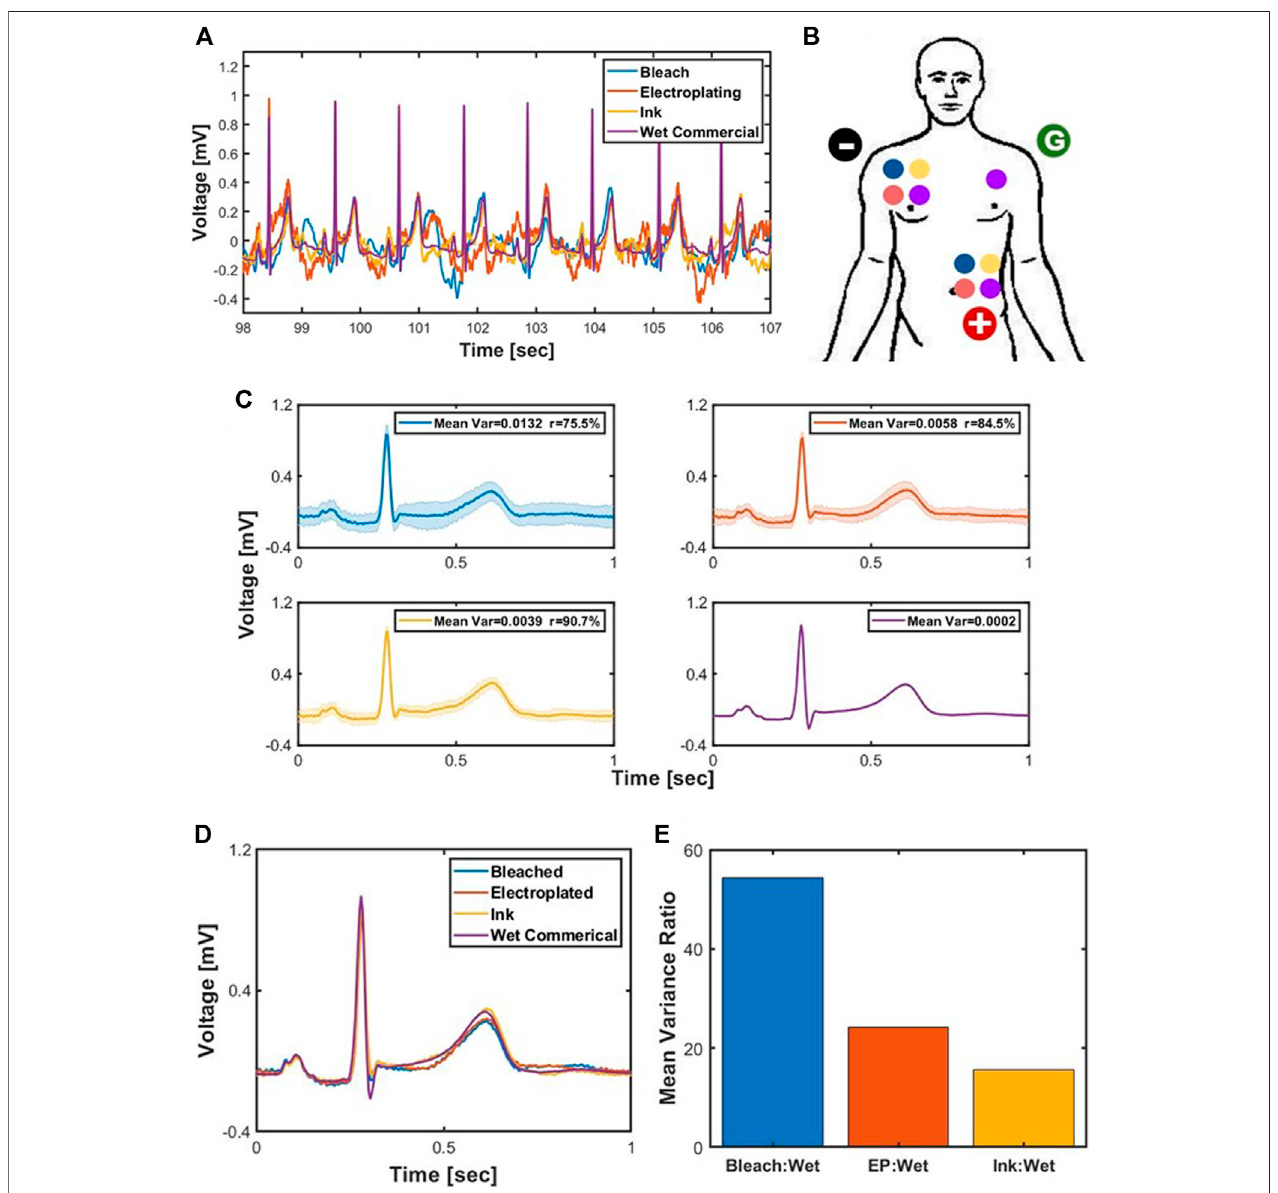
FIGURE2| ECGrecordingandanalysiswherethebluegraphisforbleached,orangeforelectroplating,yellowforink,andpurpleforwetcommercialelectrode. (A) Time-series ECG recordings of the electrodes. (B) Placement of the electrodes for lead II. (C) Subplot of ECG average with mean and error along with its variance. (D) Overlay of the average of the ECG waveform for each electrodes. (E) Ratio of the mean variance for bleach, electroplating (EP), and ink to the mean variance of wet.